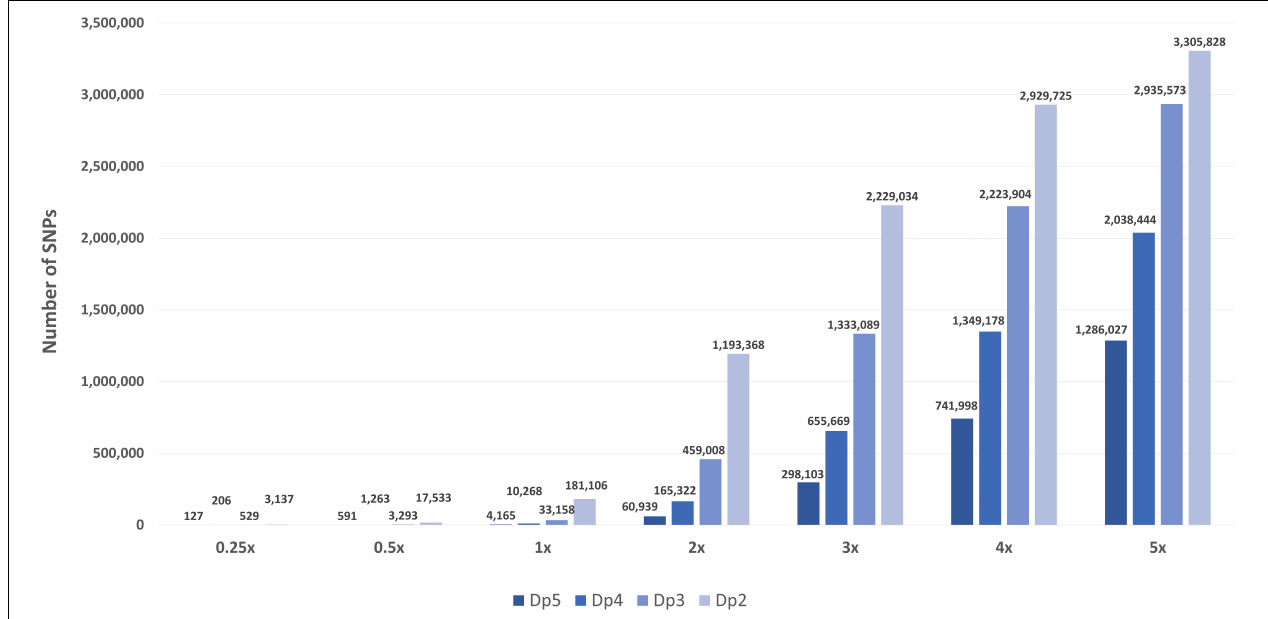
FIGURE 1 | The number of high-confidence SNPs in the global diversity panel for each skim coverage level (0.25x, 0.5x, 1x–5x) and minimum read depth (dp 5, dp 4, dp 3, and dp 2).